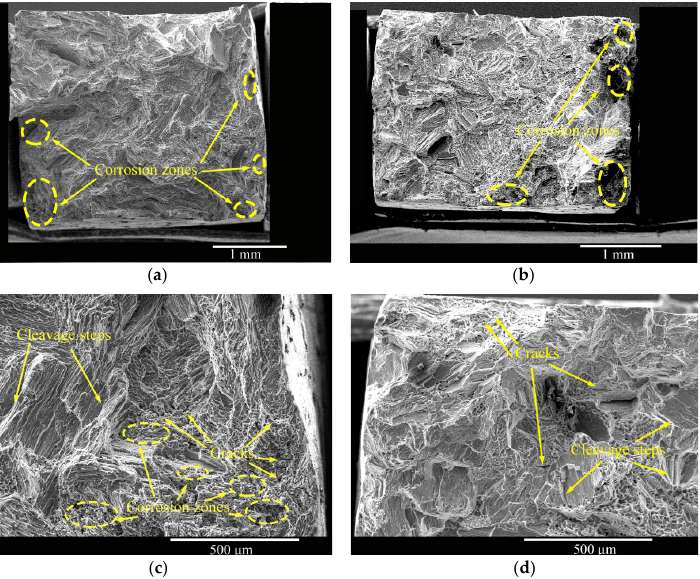
Figure 12. Fracture morphologies of the ( a , c ) as-cast and ( b , d ) solid-solution-treated AM50 magne- sium alloy samples SSRT tested after pre-immersion in 3.5% NaCl solution for 24 h.